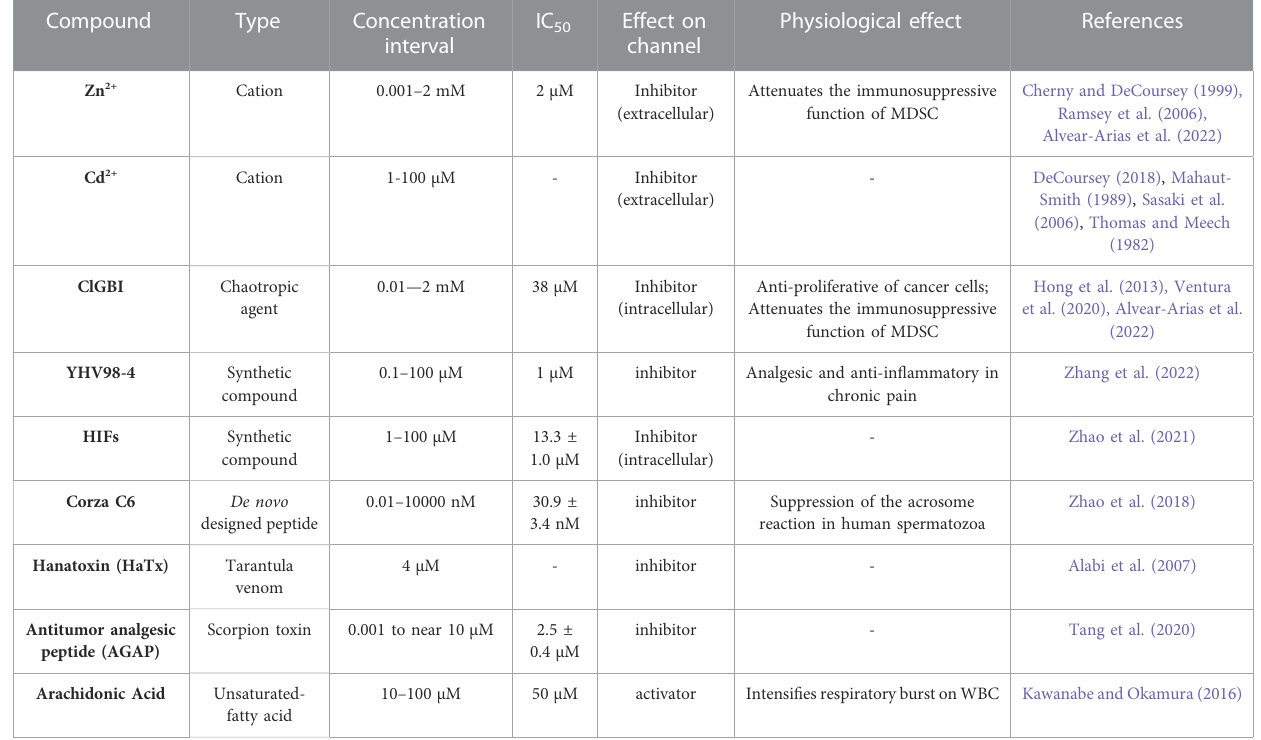
TABLE 1 Pharmacological modulators of Hv1 channel activity and its physiological